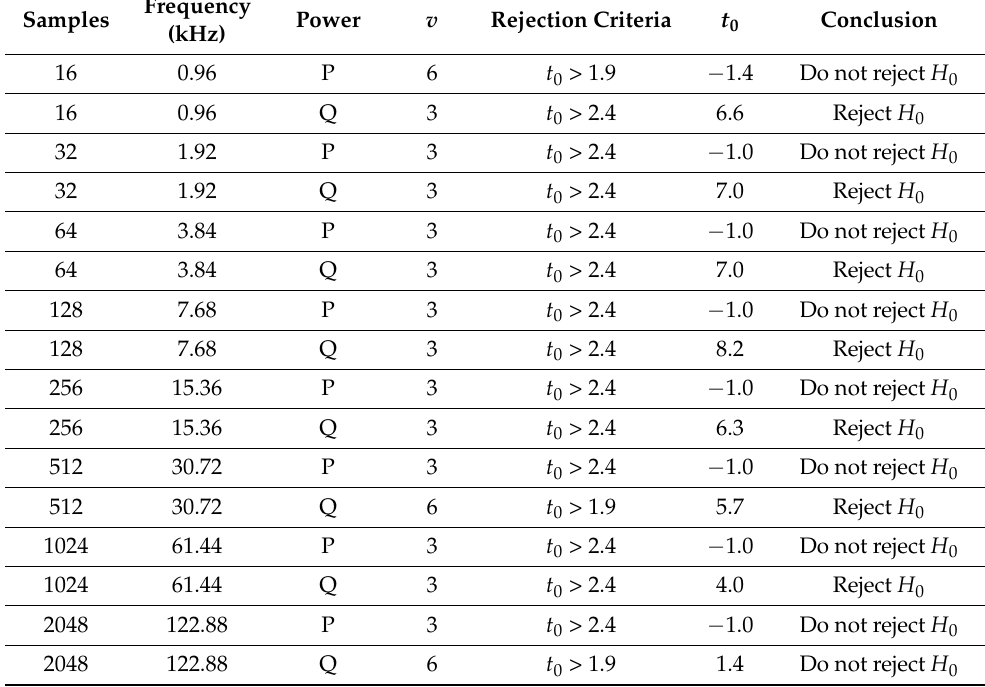
Table 17. Hypothesis test for the non-linear